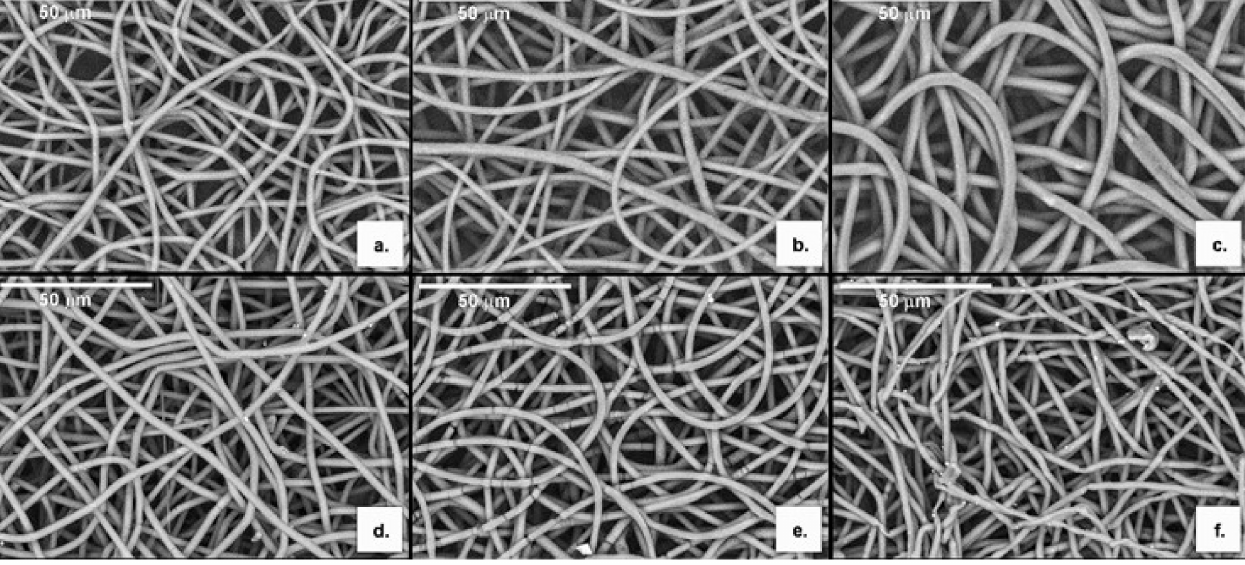
Figure 5. Images obtained by Scanning Electron Microscopy (SEM) analysis of the electrospun P(3HB), P(3HB-co-3HV) and P(3HB-co-3HV): mcl-PHA (70:30) blend scaffolds ( a – c , respectively); SEM imaging of the electrospun fibers after 12 min of oxygen plasma exposure ( d – f ,